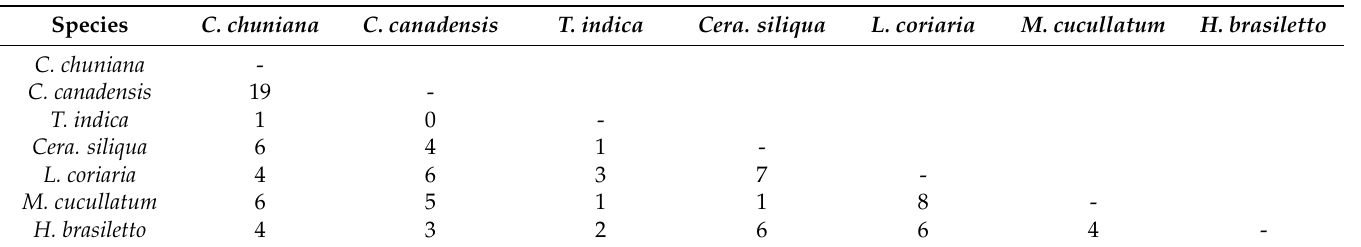
Note: The numbers in parentheses are the percentage of each region or SSR types. Table 4. Shared SSRs among the seven species in caesalpinioid